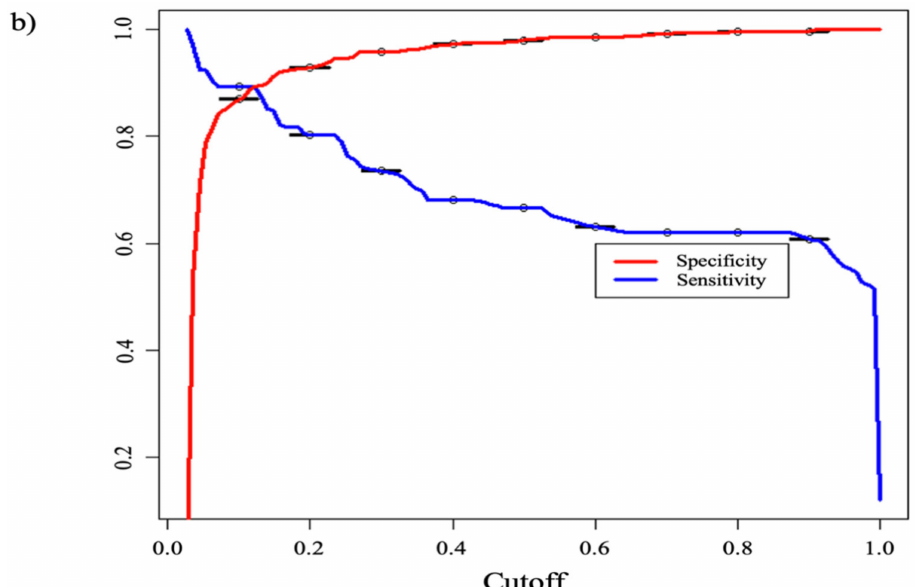
Figure 3. The receiver operating characteristic curves of the serum amyloid A (SAA) concentration to identify healthy or diseased groups of Japanese Black breeding cows. ( a ) representative cut-off values of each probabilities. Area under the curve: 0.940, p -value: 3.338084 × 10 − 29 , Accuracy: 0.8901408, Sensitivity: 0.8787879, Specificity: 0.8927336, Precision: 0.6516854, Cut-off SAA value: 6.5 mg/L, Probability: 0.1220142, ( b ) Trade-off between Specificity and Sensitivity across the range of possible